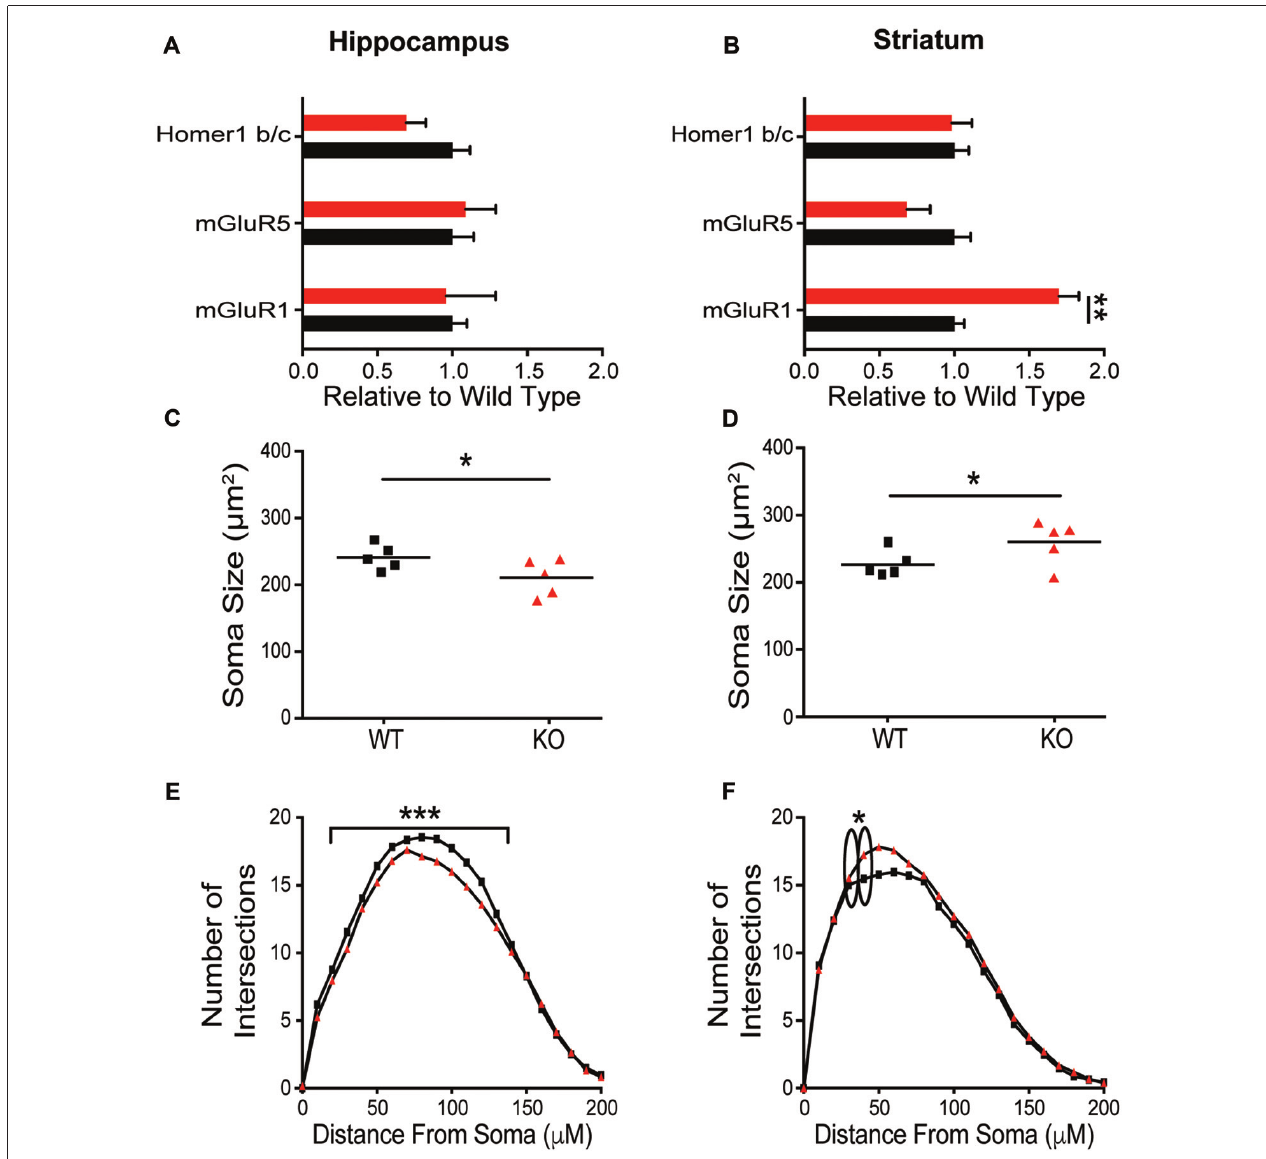
FIGURE 5 | Differential molecular alterations in the hippocampus (HP) and striatum resultant of Shank2 mutations. Shank2 mutation does not alter the expression of synaptic proteins ( Supplementary Figure S2 ) or metabotropic glutamate receptor related proteins in the HP (A) . Values are expressed as fold change relative to the average WT value. The soma size of CA1 hippocampal pyramidal (HPp) neurons is smaller in KO relative to WT rats (B) and there is a reduction in basilar dendritic arborization (C) as evidenced by Golgi staining and quantification. However, in medium spiny neurons (MSNs) of the striatum, detailed analysis reveals an upregulation of mGluR1 protein expression in male KO rats (D) despite a lack of change in synaptic protein level ( Supplementary Figure S2 ). Striatal MSNs in contrast to HPps of KO rats have larger soma (E) and increased proximal dendritic branching (F) relative to WT animals. In all panels WT animals are in black and KO animals are in red. Bars indicate SEM. ∗ p < 0.05, ∗∗ p < 0.01, ∗∗∗ p < 0.001.